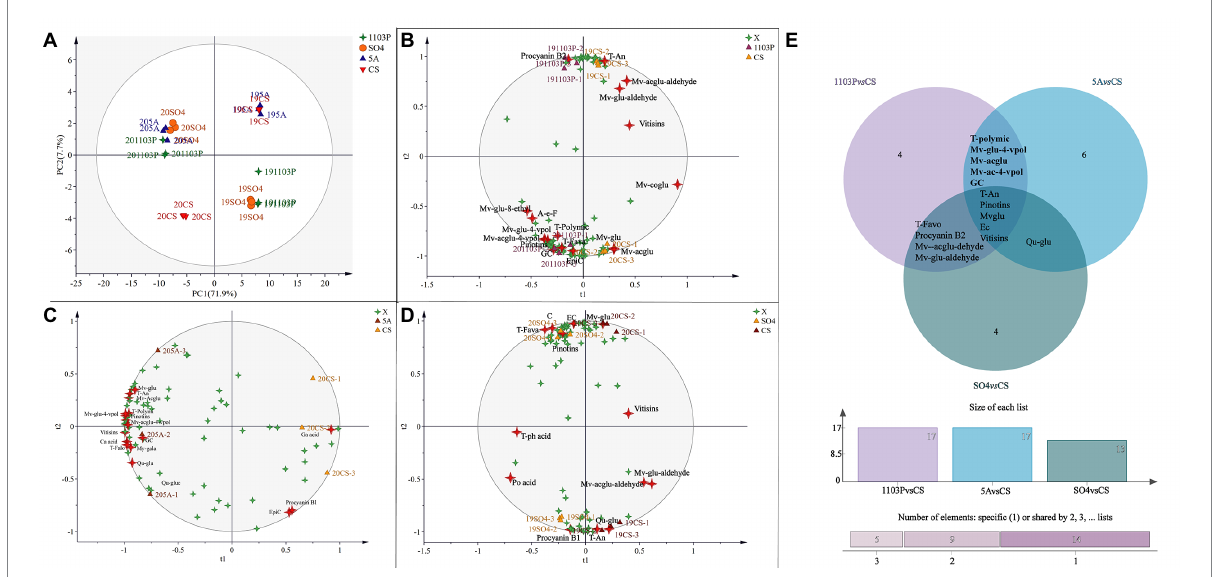
FIGURE 4 Principal component analysis (PCA) based on flavonoid compound concentrations of wine in two vintages (2019–2020) (A) ; OPLS-DA based on flavonoid compound concentrations of wine in two vintages (2019–2020) (B–D) ; Venn diagram based on differential compounds (VIP > 1) in wines (E) . The abbreviated names of the substances in the figure are shown in Supplementary Table